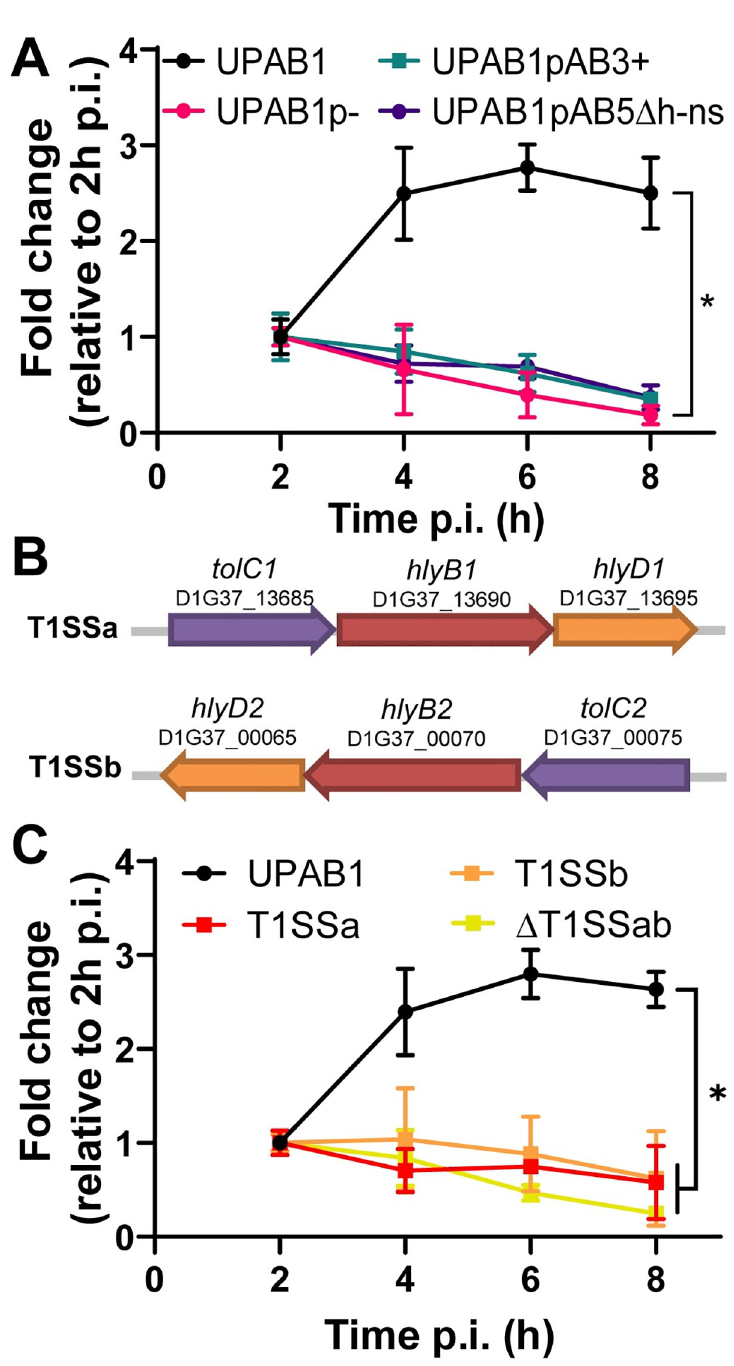
Fig 6. pAB5 and T1SS are required for UPAB1 intracellular replication. (A) J774A.1 macrophages were infected with the indicated strains. UPAB1p-, UPAB1pAB3+ and UPAB1pAB5 Δ h-ns strains were not able to replicate. Data represents mean and standard deviation values for 3 independent experiments. � p < 0.05. (B) Genetic organization of the T1SSa and T1SSb loci. (C) Individual and double T1SS mutants have a defect in intracellular replication in J774A.1 macrophages. Data represents mean and standard deviation values, for 3 independent experiments. � p < 0.05.